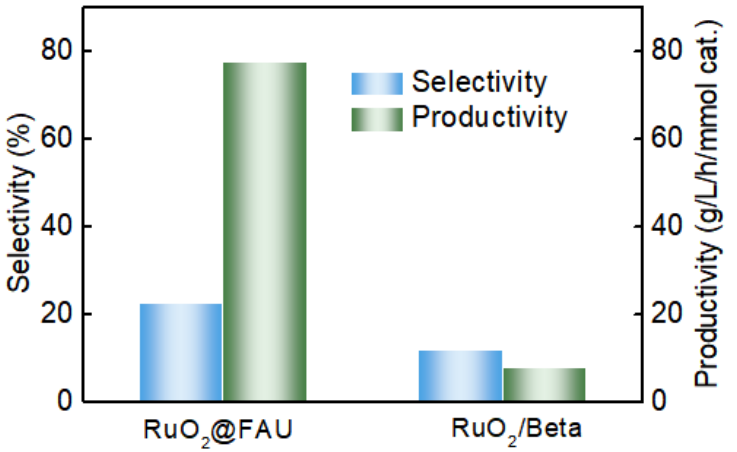
Figure 4. Performance comparison of decarboxylation of L-lysine to cadaverine between RuO 2 @FAU with the traditional supported RuO 2 /Beta catalyst with similar activity. The reaction conditions are as follows: L-lysine (0.1 M), Ru catalysts (1.01 g), 200 °C, 800 rpm, 2 MPa H 2 .